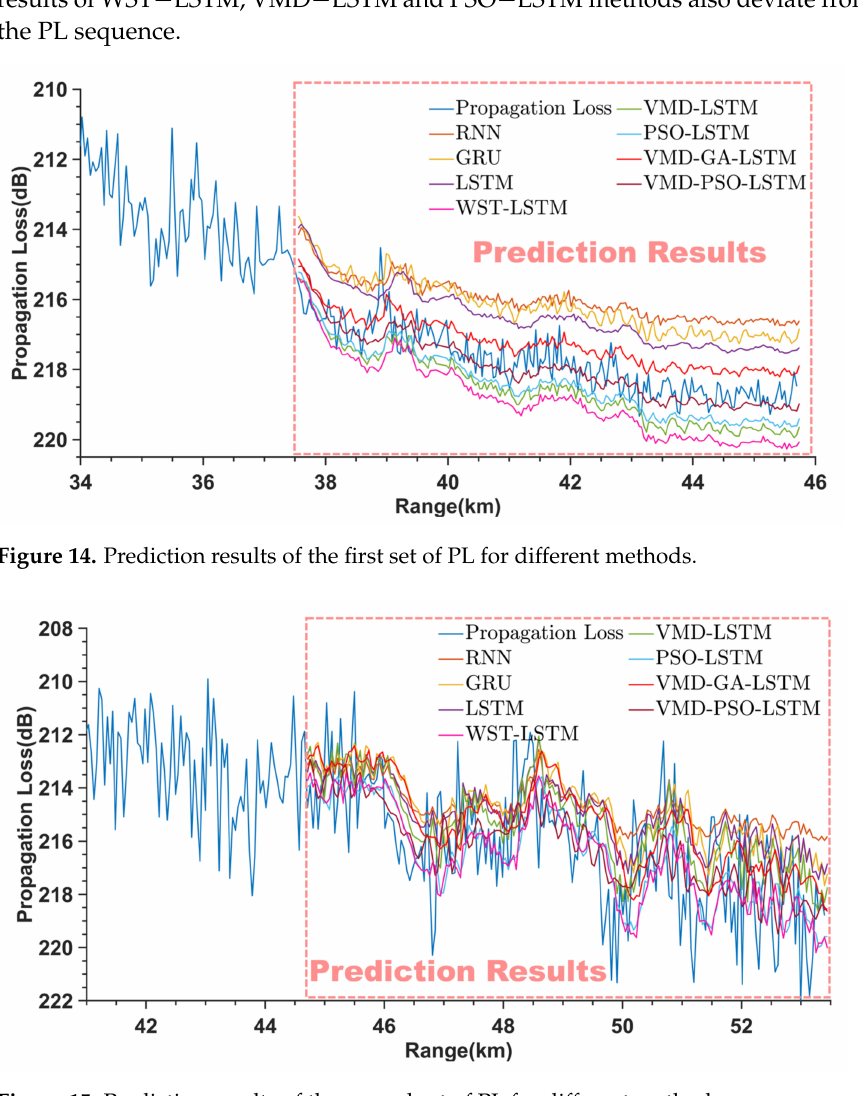
Figure 15. Prediction results of the second set of PL for different